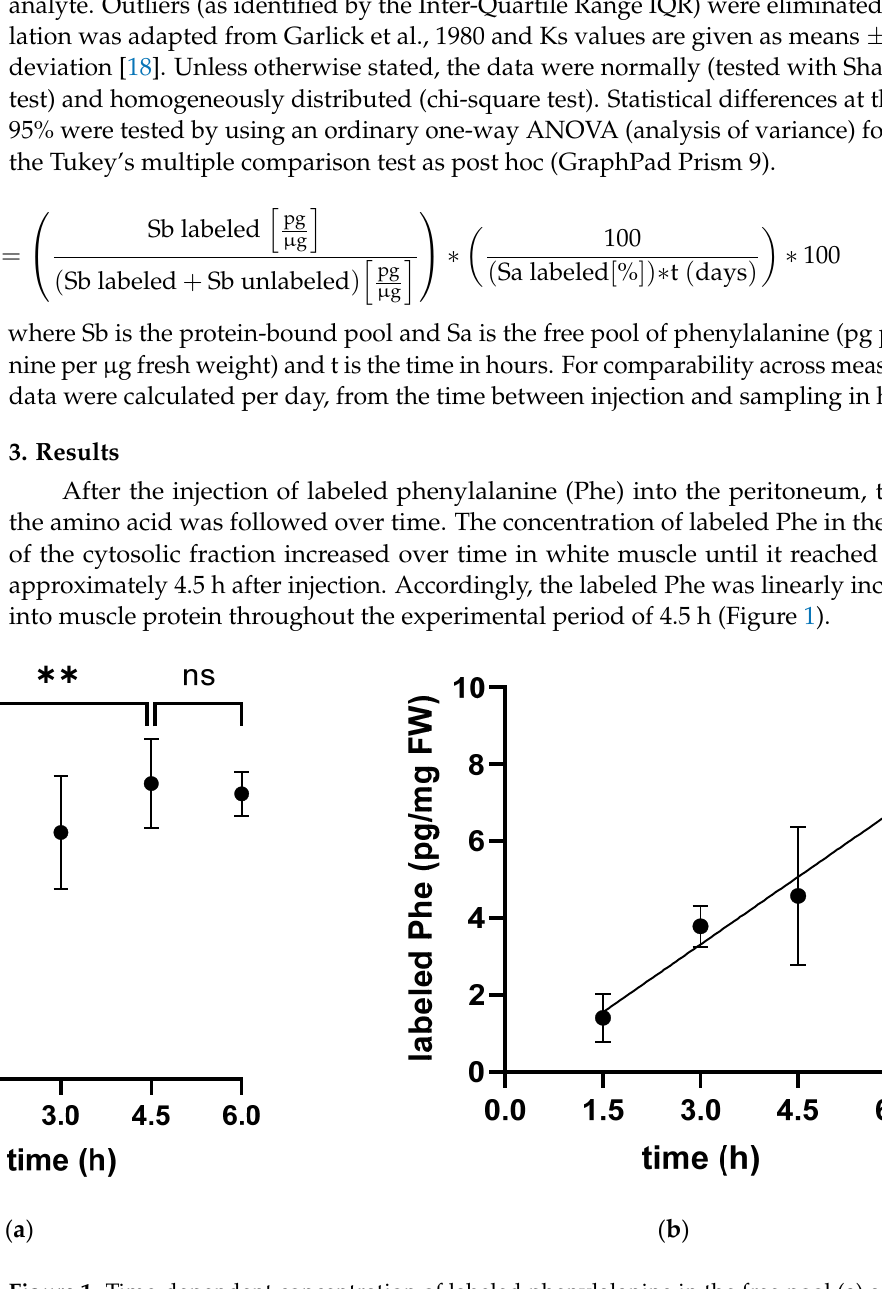
Figure 1. Time-dependent concentration of labeled phenylalanine in the free pool ( a ) and protein- bound ( b ) in white muscle tissue extracts of the Antarctic eelpout Pachycara brachycephalum kept at 0 ◦ C. The concentration of labeled phenylalanine in the free pool ( a ) increased until reaching a plateau after 4.5 h and at a level of 900 pg/mg FW (Fresh weight) (** p < 0.005, ns p > 0.05). In contrast, the concentration of protein-bound phenylalanine ( b ) increased linearly over time up to 7 pg/mg FW (y = 1.174x − 0.2087; R2: